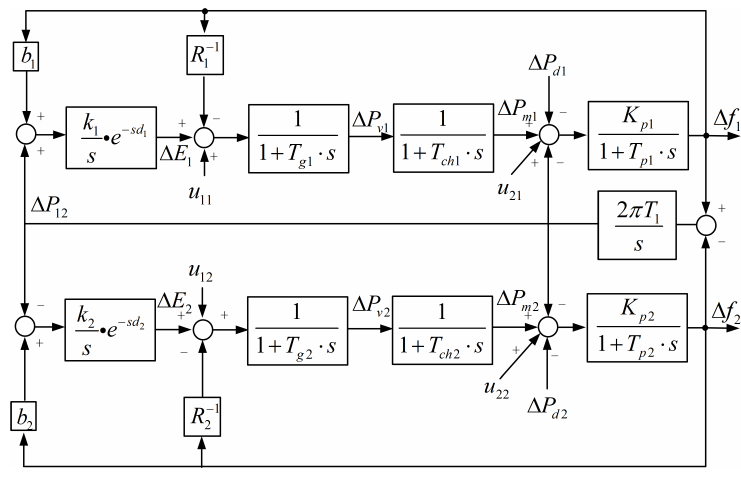
Figure 2. Two-area LFC system model considering